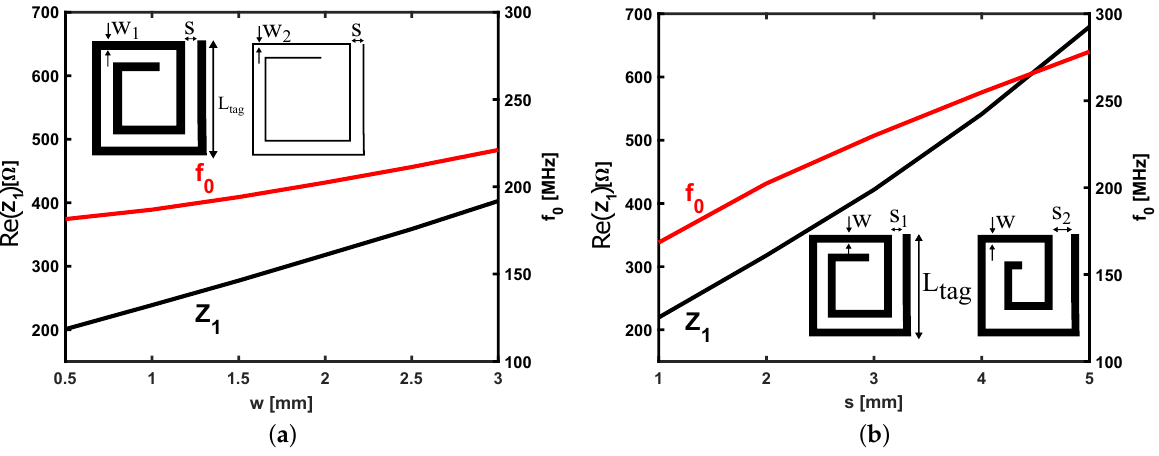
Figure 7. ( a ) Effect of the trace width w on the input impedance at the probe terminals and the resonant frequency of the SR. Results are plotted for L p = L tag = 50 mm, s = 2 mm, N = 2 turns, and d z = 20 mm. ( b ) Effect of the trace separation s on the input impedance at the probe terminals and the resonant frequency of the SR. Results are plotted for L p = L tag = 50 mm, w = 2 mm, N = 2 turns, and d z = 20